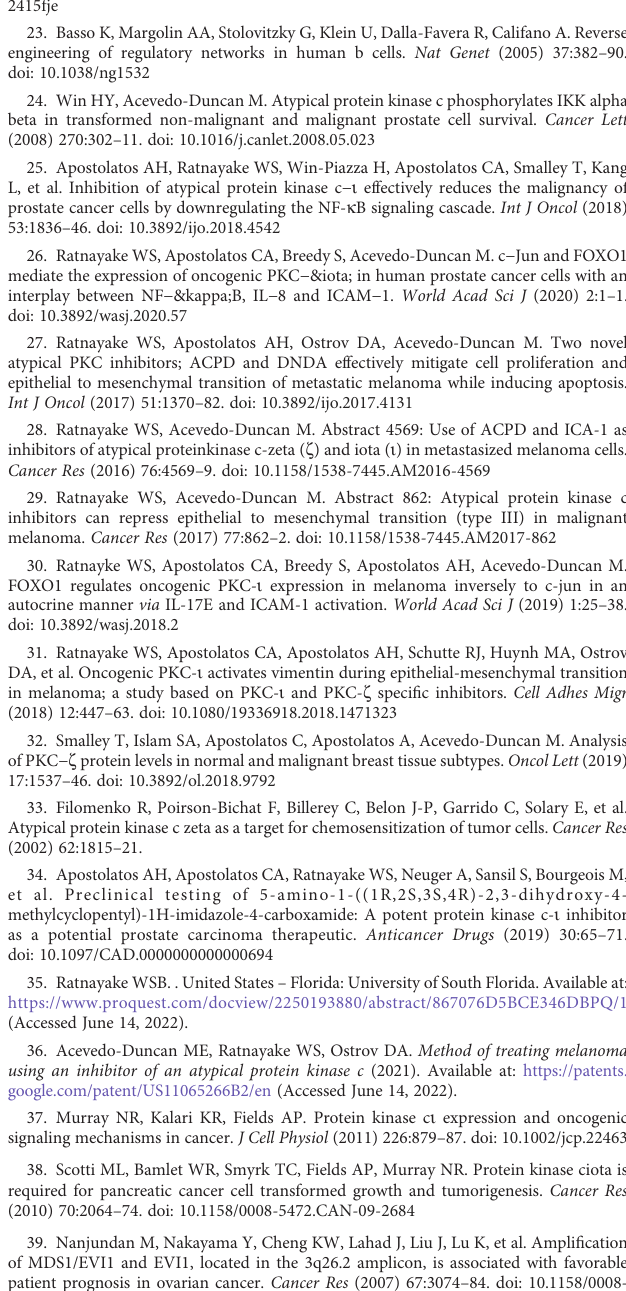
SUPPLEMENTARY FIGURE 2 Preliminary data on effects of con fl uency and siRNA on aPKC expression. (A) Westernblots showing aPKCexpression basedoncon fl uencyinBE(2)-C andBE (2)-M17. (B) Western blots showing effects of siRNA knockdown of aPKCs on 14-3-3, Smad 2/3, Cdk7 and